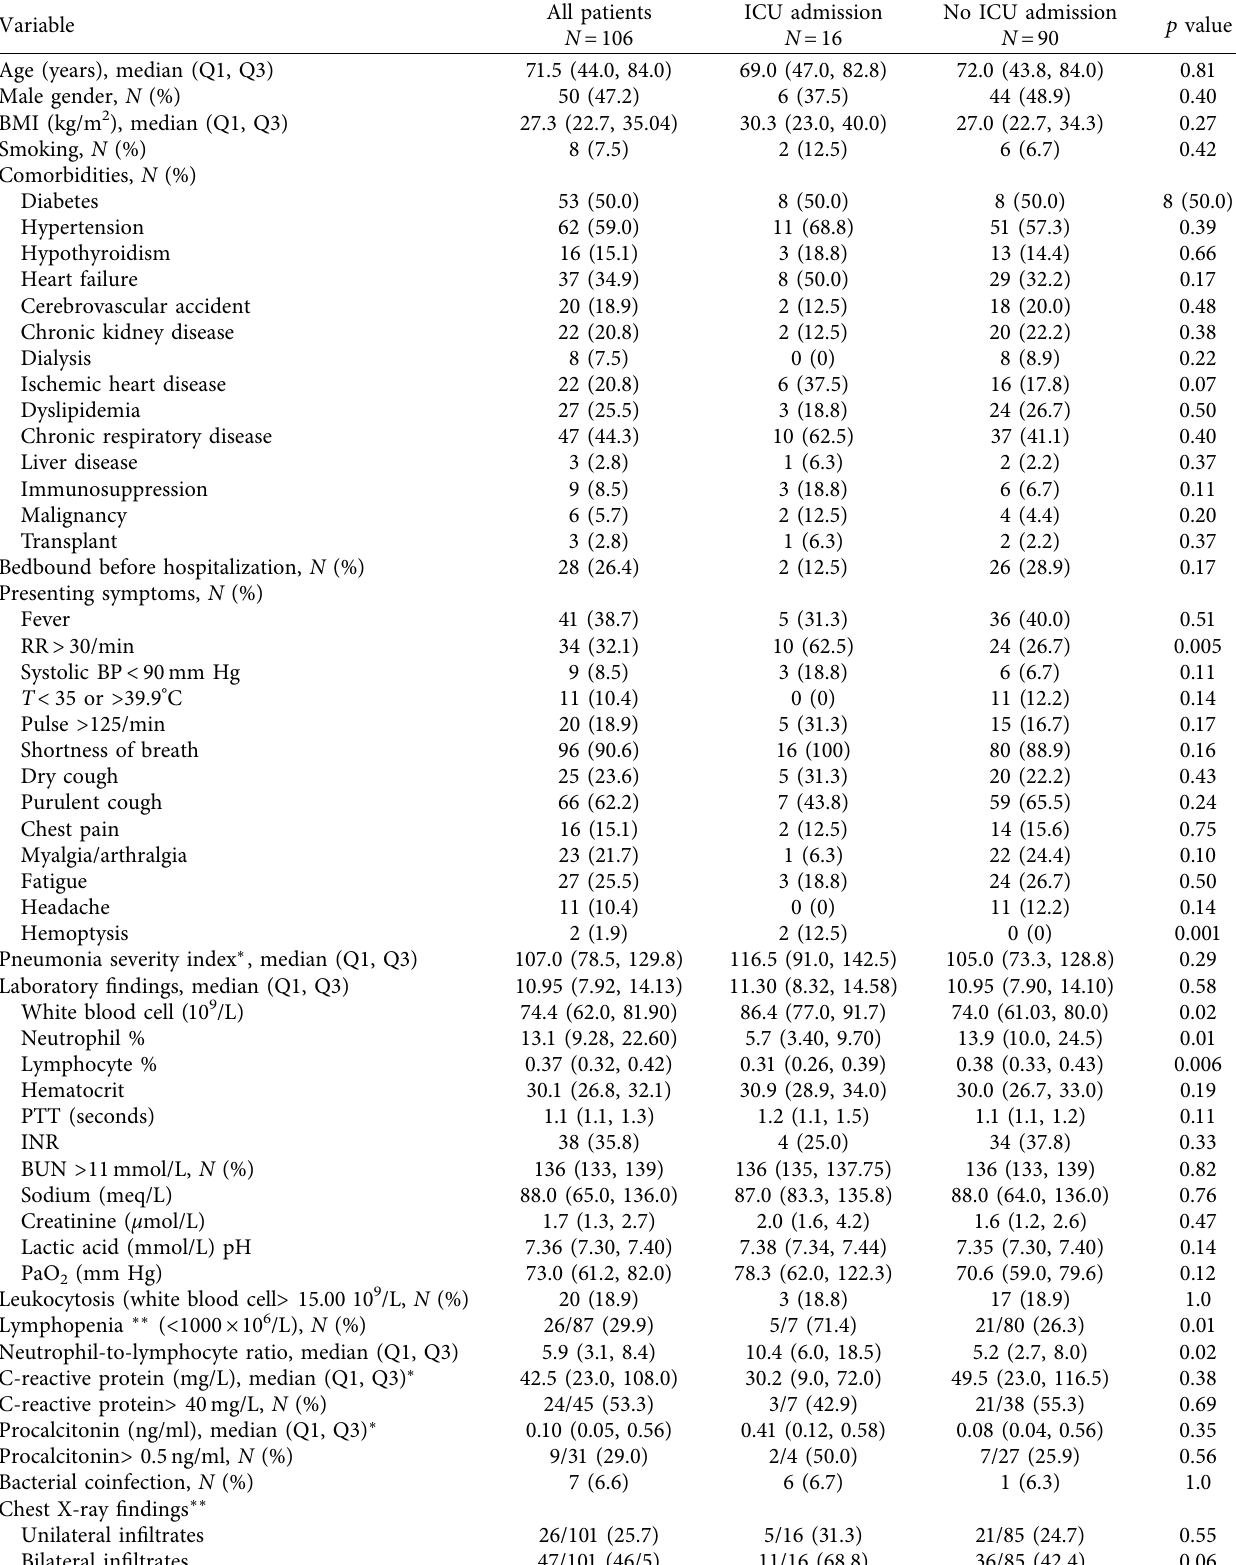
Table 1: Characteristics of patients admitted with rhinovirus pneumonia.